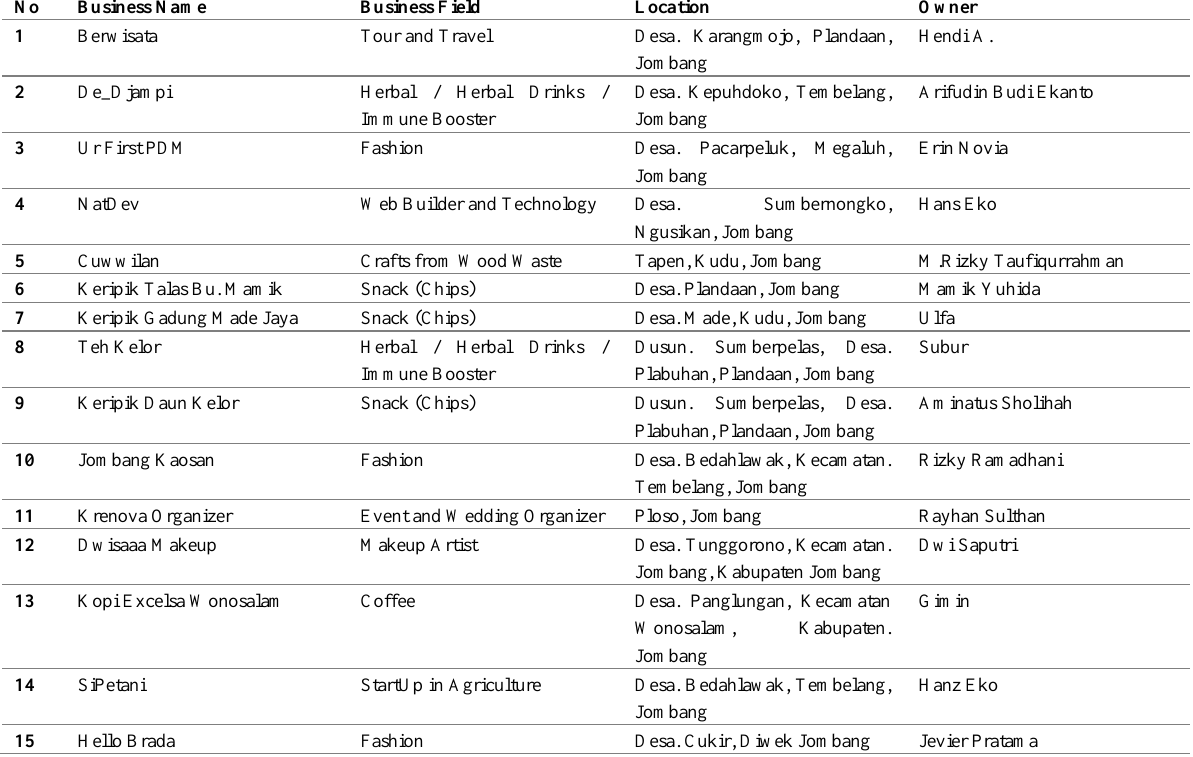
Table 1: List of Creative Industries, SMEs (UKM) and Startups fostered through Ruang Inovasi Jombang Business Incubator